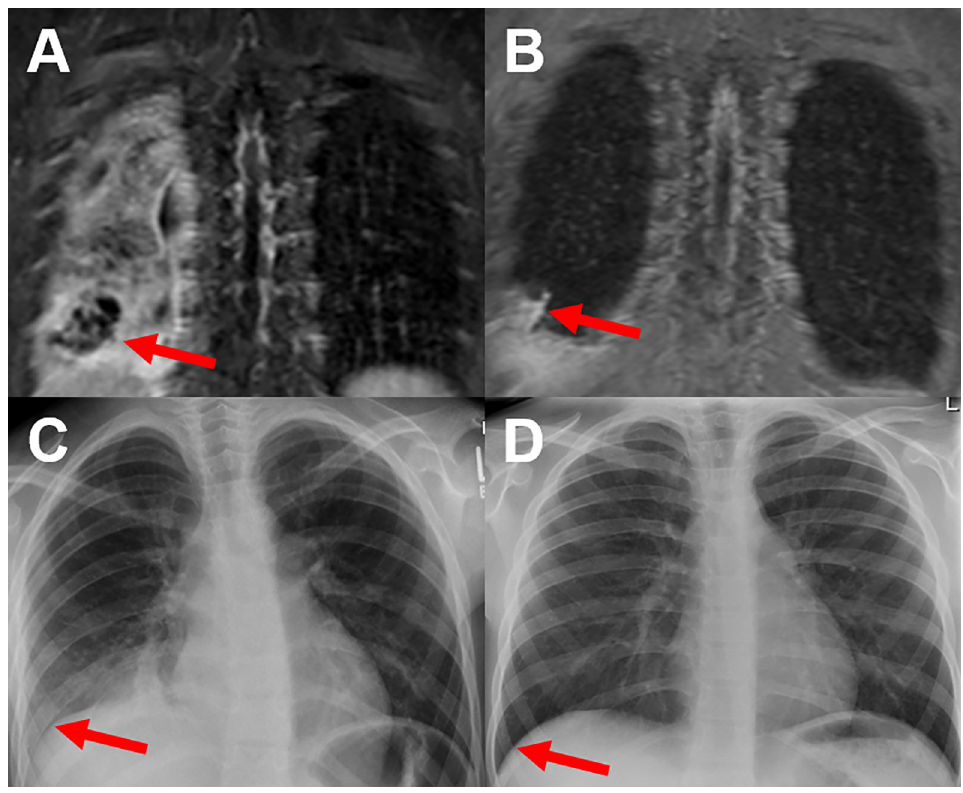
Fig 4. Comparison of T2-weighted sequences and CXR of a 9-year-old child at baseline and follow-up. MRI shows an abscess formation in the right lower lobe at baseline (red arrow) (A), which has regressed under therapy at follow-up (red arrow) (B). The corresponding CXR (C) shows a slight reduction in transparency in the right lower lung field without any clear evidence of an abscess (red arrow). At follow-up, CXR (D) shows no pathological findings not delineating the full extent of residual inflammatory changes (red arrow).